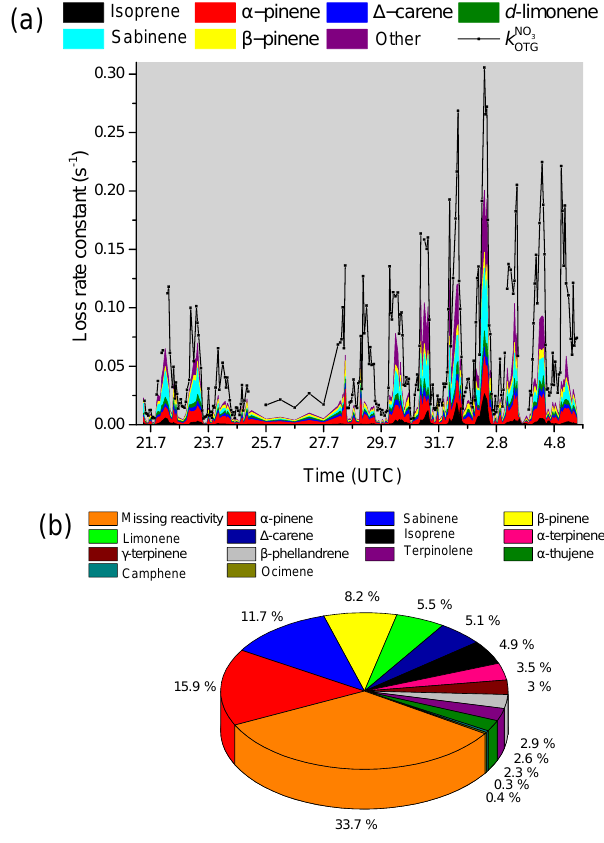
Figure 4. (a) Measured values of k NO 3 (black) compared to the OTG loss rate constant attributed to individual VOCs. The term “other” includes terpinolene, β -phellandrene, α -terpinene, γ -terpinene, α - thujene, and camphene. Myrcene and α -phellandrene were also measured but below the detection limit during the whole campaign. The pie chart (panel b ) indicates the campaign-averaged contribu- tion of each measured VOC to the NO 3 loss rate as well as reactivity that could not be attributed to measured VOCs (“unassigned reac-